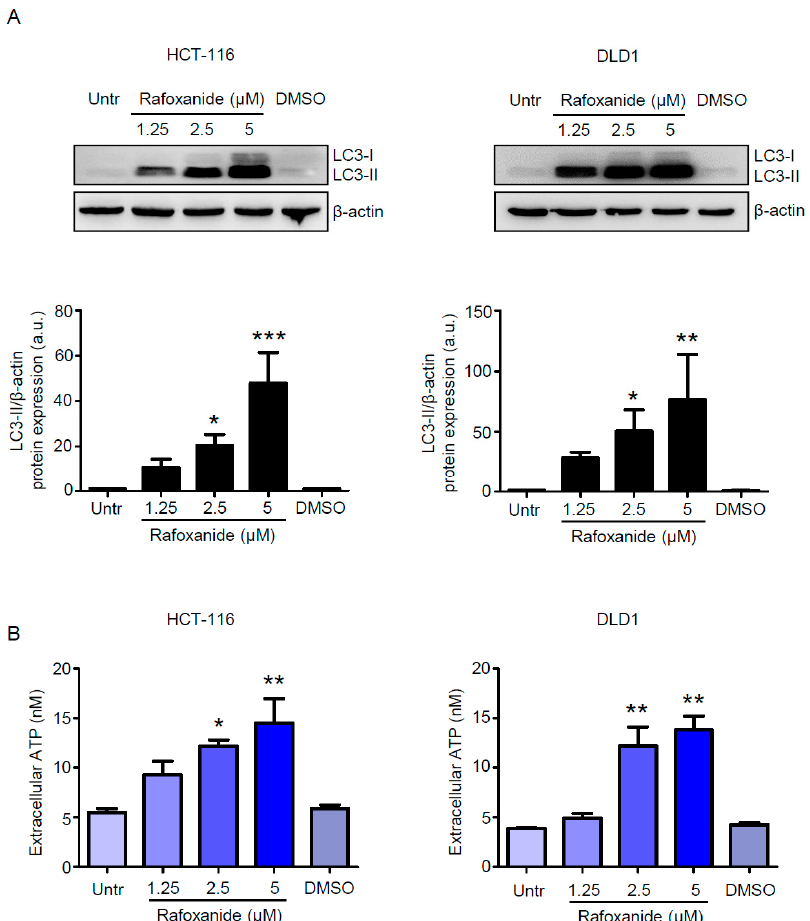
Figure 2. Rafoxanide induces autophagy and ATP release in CRC cells. ( A ) Western blotting for LC3 in extracts of HCT-116 and DLD1 cells either left untreated (Untr) or treated with either DMSO (vehicle) or rafoxanide for 24 h. β -actin was used as loading control. The full blots are available in Figure S3 from Supplementary Materials. One of three experiments in which similar results were obtained is shown. Lower insets: Quantitative analysis of LC3-II / β -actin protein ratio in total extracts of HCT-116 and DLD1 as measured by densitometry scanning of Western blots. Values are expressed in arbitrary units (a.u.) and are the mean ± SD of three experiments. Data were analyzed using one-way analysis of variance (ANOVA) followed by Dunnett’s post hoc test. DMSO vs. rafoxanide-treated cells, * p < 0.05, ** p < 0.01, *** p < 0.001. ( B ) Histograms showing the amount of released ATP in the medium supernatant of HCT-116 and DLD1 cells either left untreated (Untr) or treated with either DMSO or rafoxanide for 24 h. Data are expressed as mean ± SD of three experiments. Data were analyzed using one-way analysis of variance (ANOVA) followed by Dunnett’s post hoc test. DMSO vs. rafoxanide-treated cells, * p < 0.05, ** p < 0.01.